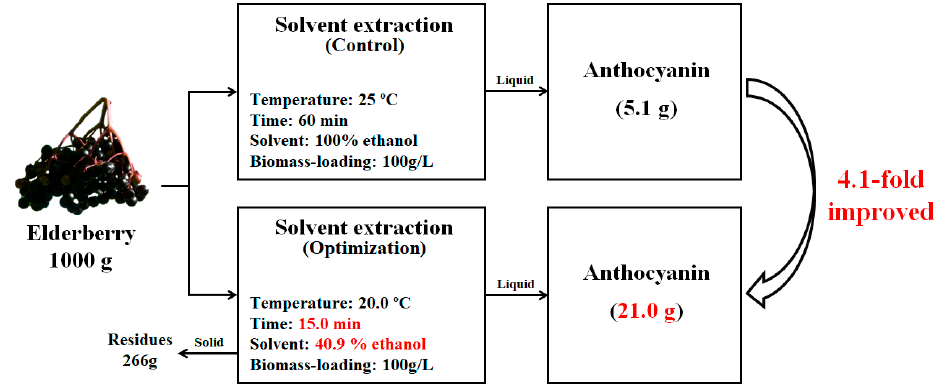
Figure 3. Mass balance of recovered anthocyanin based on 1000 g of elderberry. Table 7 summarized recent studies on anthocyanin recovery from berries. Anthocy- anin was recovered from berries such as bilberry, blackberry, blue honeysuckle berry,